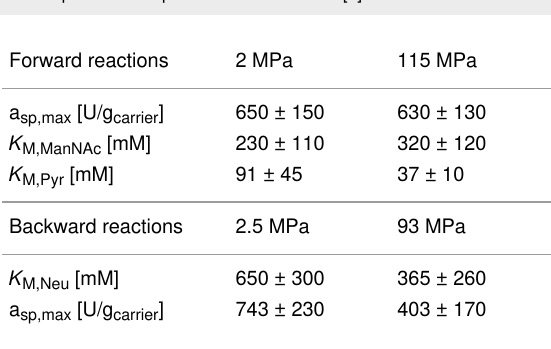
Table 5: Calculated kinetic parameters at ambient and high pressure. Rate expression adopted from Groher et al. [8].